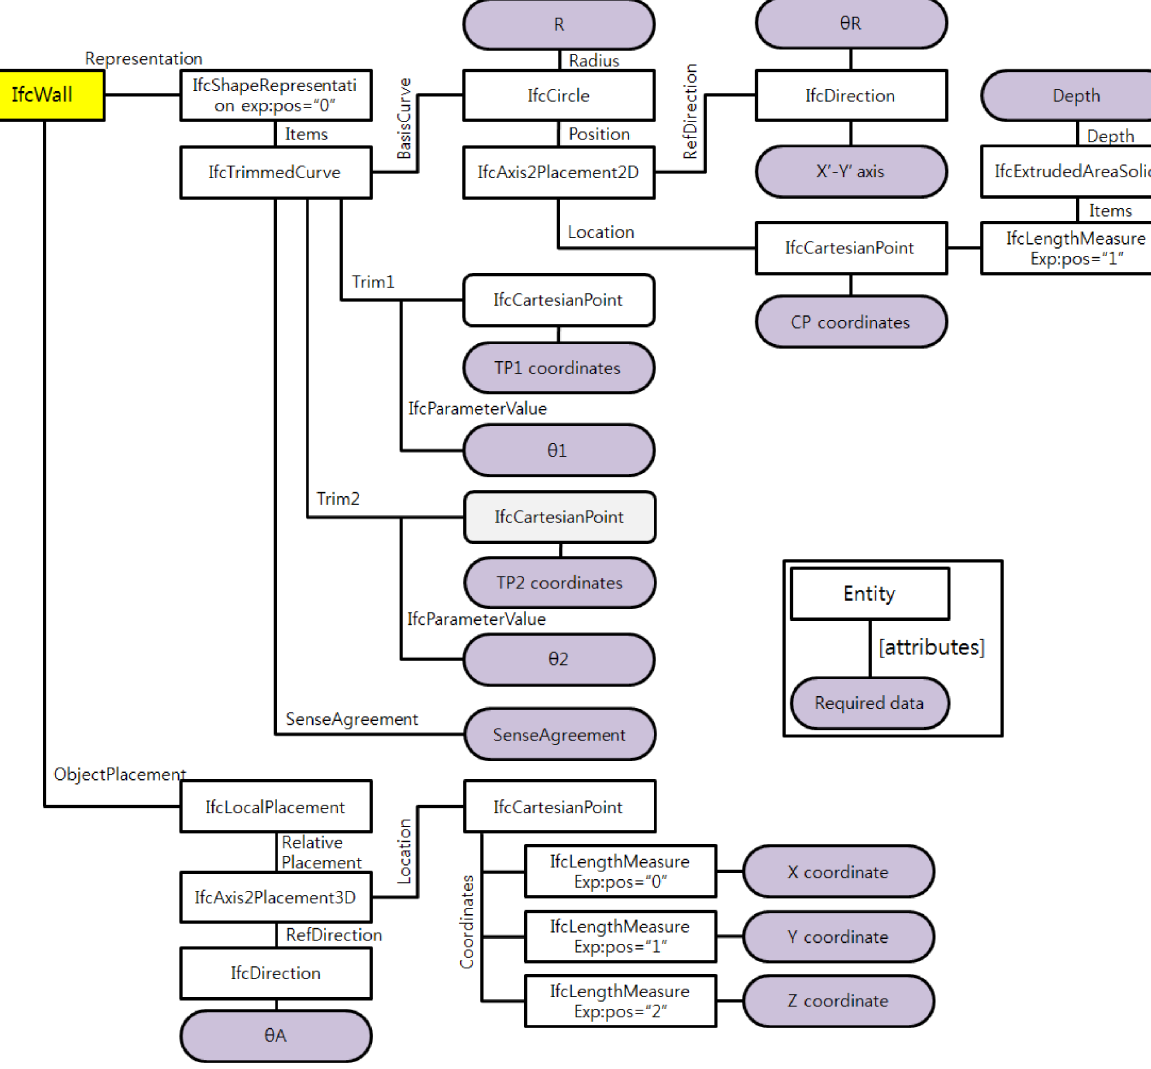
Fig. 2. Data extraction path in